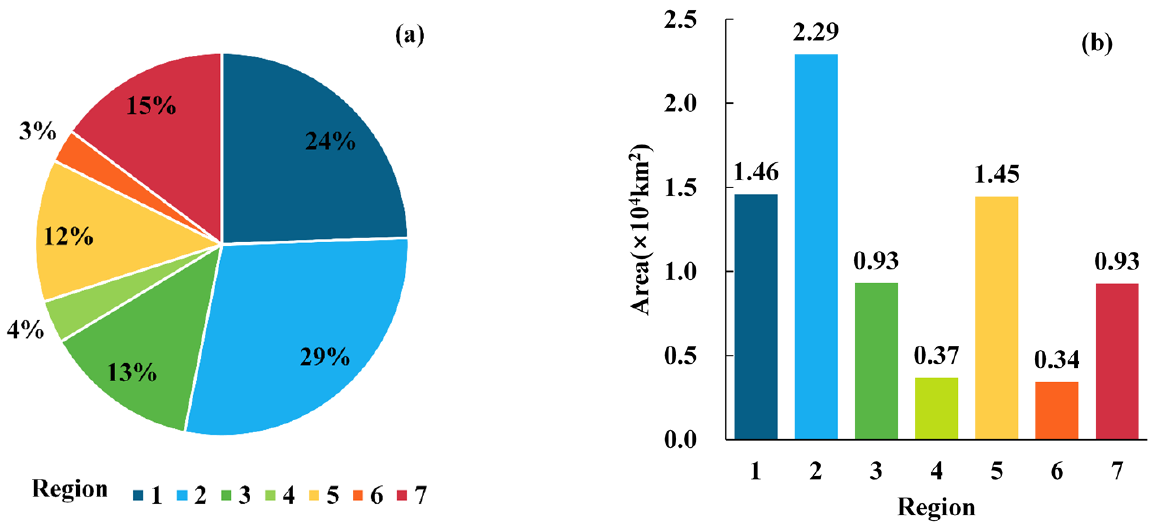
Figure 10. ( a ) Proportion of impervious surface area in different regions (2018); ( b ) Increased area of impervious surface from 2015 to 2020 in different regions.